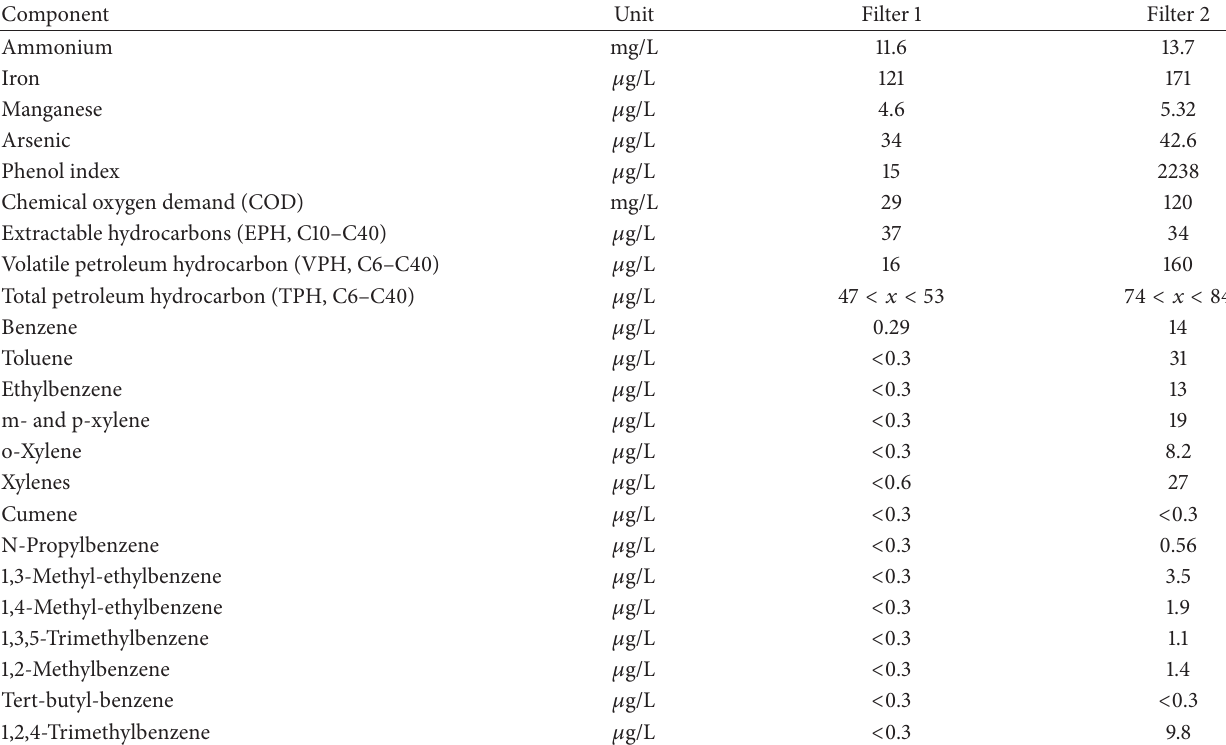
Table 1: Chemical composition of the water at each